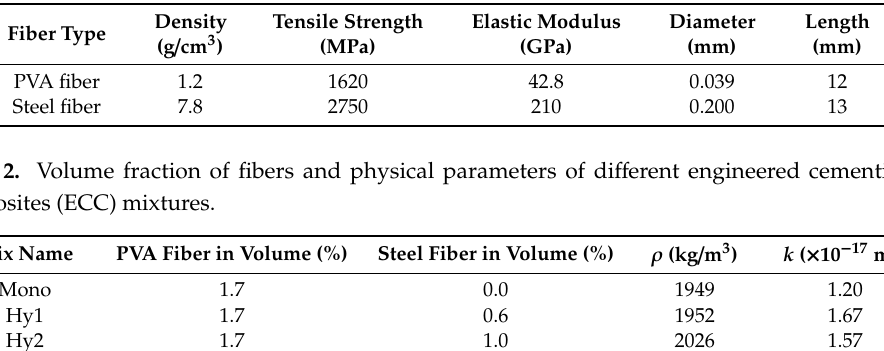
Table 1. Physical properties of polyvinyl alcohol (PVA) and steel fibers.